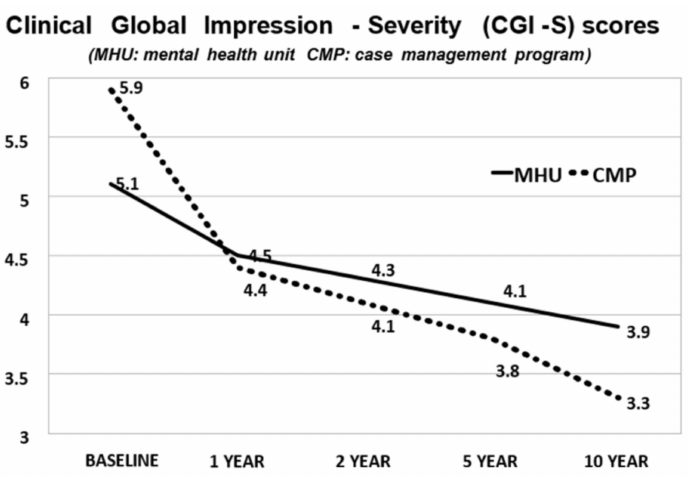
Figure 1. CGI-S Scores during the Follow-up. Mhu vs. Cmp. Gender was not related to treatment adherence, hospital admissions or